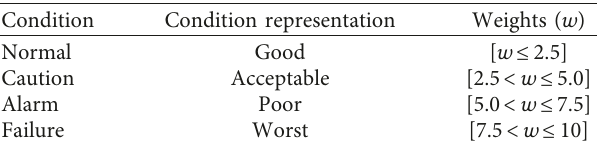
Table 3: Weights assigned to each of the parameters of the four conditions.